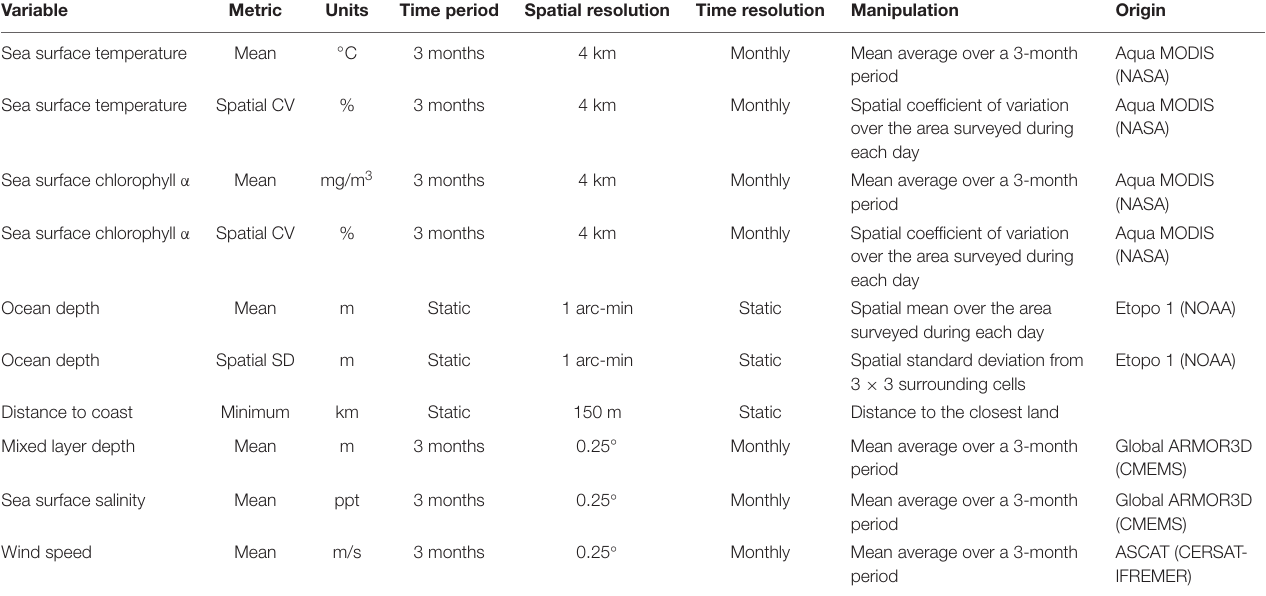
TABLE 1 | Environmental variables employed in the